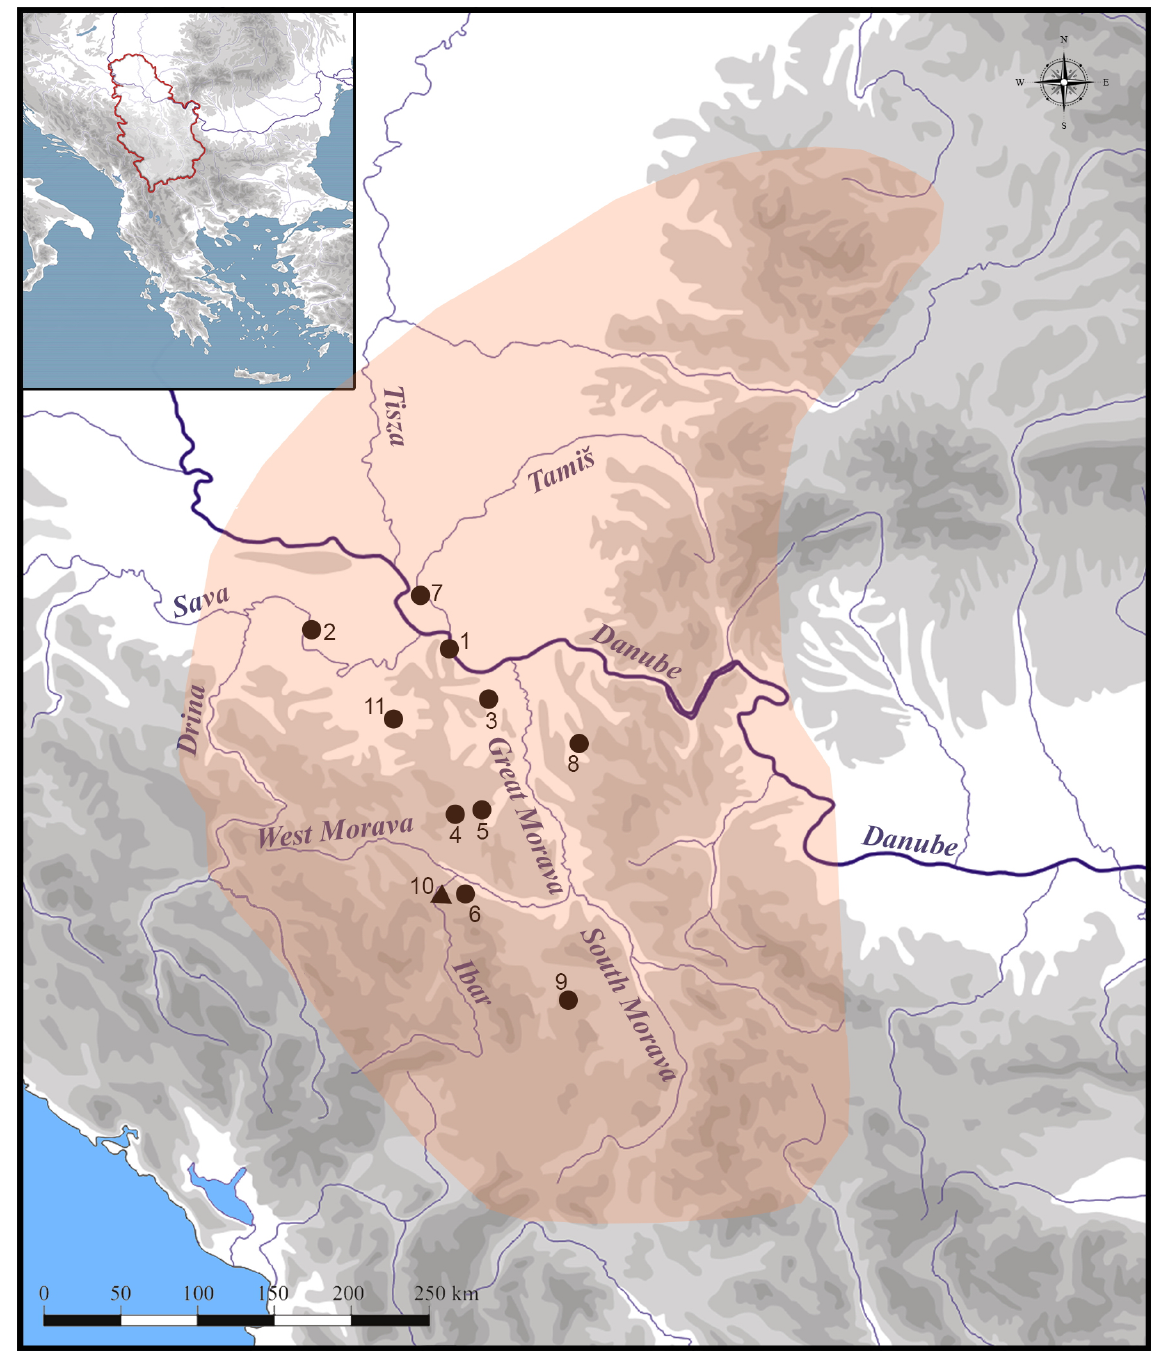
Figure 1. Approximate territory of the Vinča culture. Sites mentioned in the text: 1 Vinča -Belo Brdo, 2 Gomolava, 3 Selevac, 4 Grivac, 5 Divostin 6 Divlje polje, 7 Opovo, 8 Belovode, 9 Pločnik. 10 Lojanik mine , 11 Crkvine-Mali